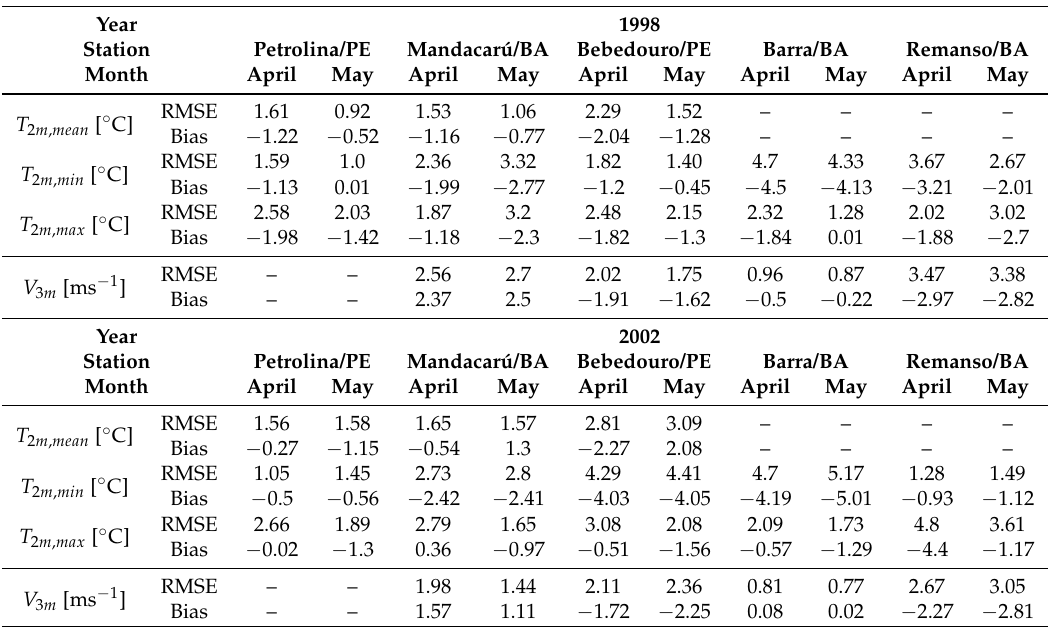
Table 1. Root mean squared error (RMSE) and bias of simulated daily mean, minimum and maximum 2m air temperatures and 3m wind speeds in comparison with observed data for the period of 1 April–31 May of the years 1998 and 2002.